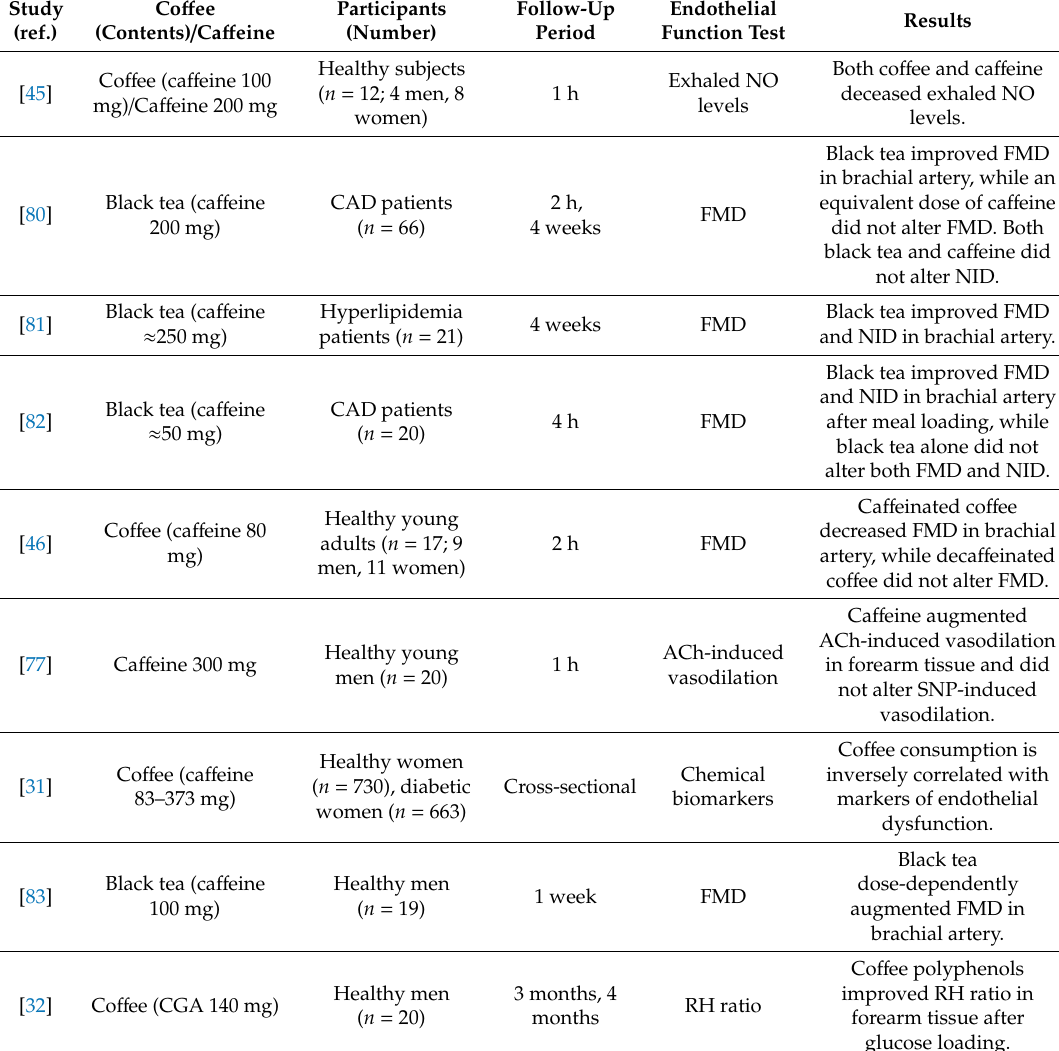
Table 1. E ff ects of co ff ee and ca ff eine on endothelial